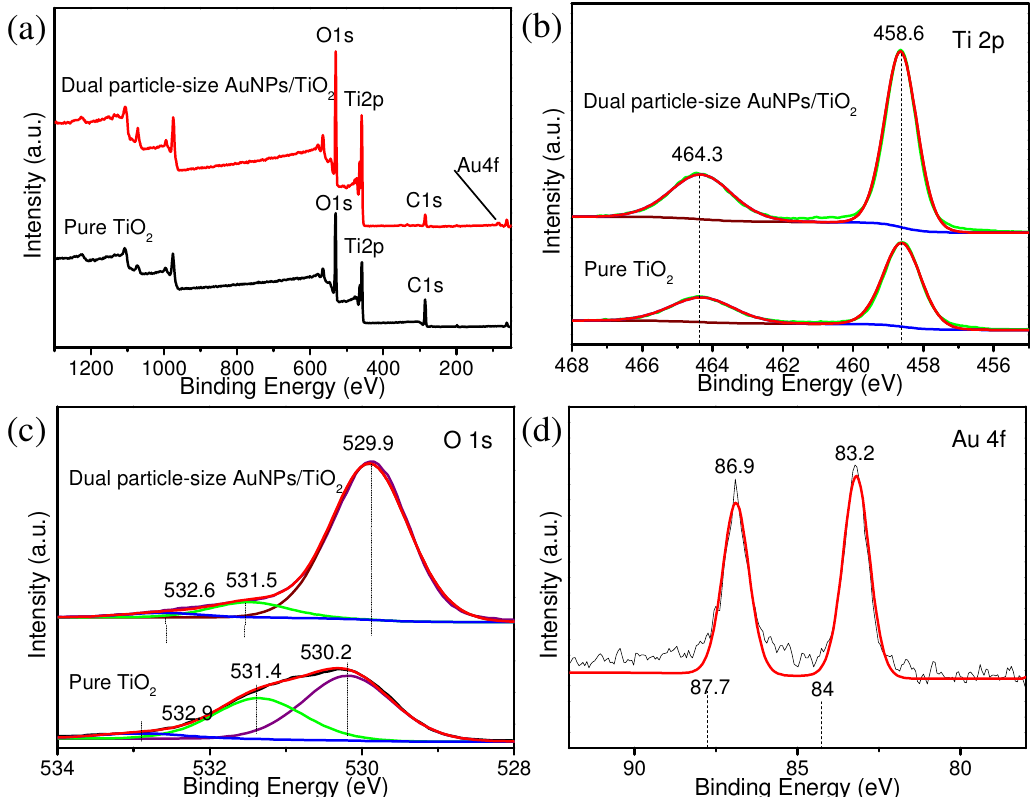
Figure 6. ( a ) Survey X-ray photoelectron spectroscopy (XPS) spectrum and high-resolution spectra of ( b ) Ti 2p, ( c ) O 1s, and ( d ) Au 4f for pure TiO 2 and dual particle-size AuNPs/TiO 2 photocatalysts.